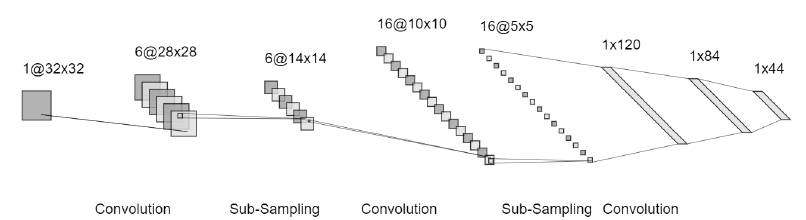
Figure 7. LeNet-5